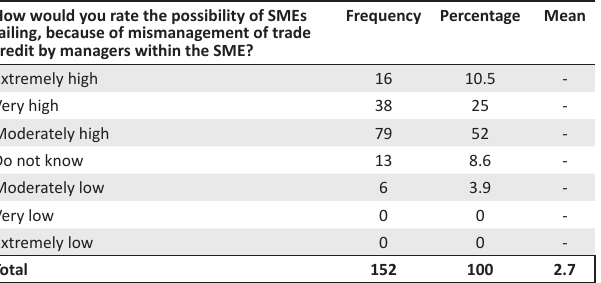
SME, small and medium-sized